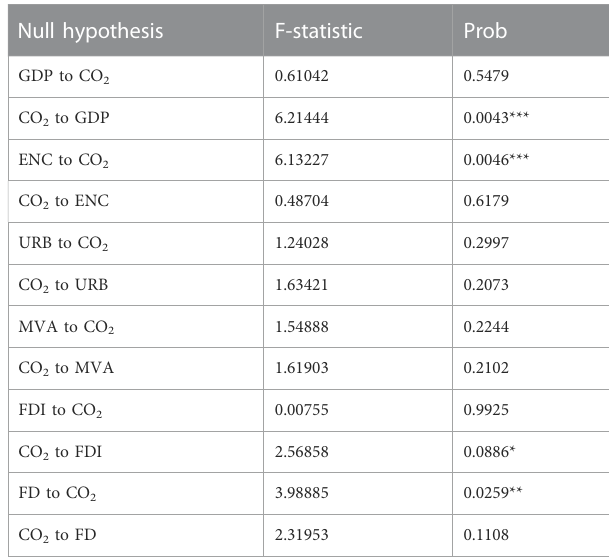
TABLE 8 Pairwise Granger Causality tests.